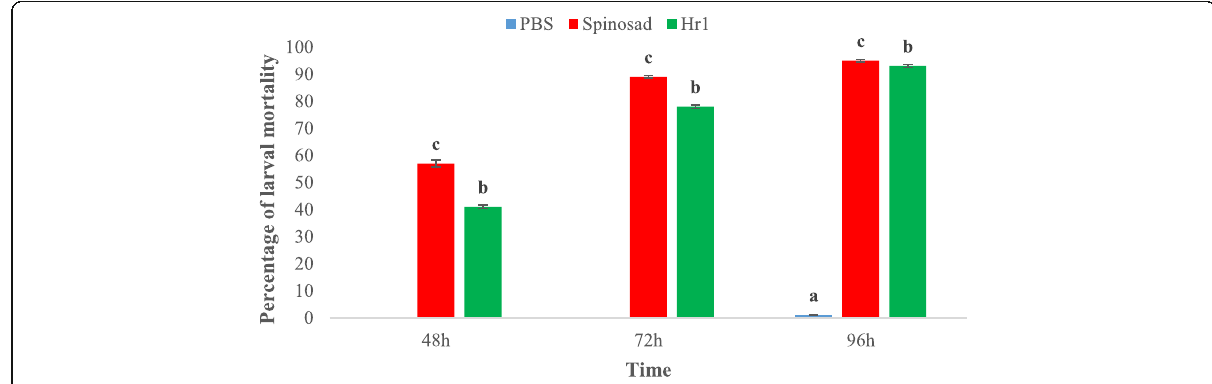
Fig. 1 Mean mortality of first instar larvae of Helicoverpa armigera exposed to a concentration of 1.8 × 10 9 CFU/ml of the bacterial isolate Hr1. Columns represent mean per cent mortality ± standard error ( n = 12). For each time interval, bars with similar alphabetic letters are not significantly different (ANOVA; P ≤